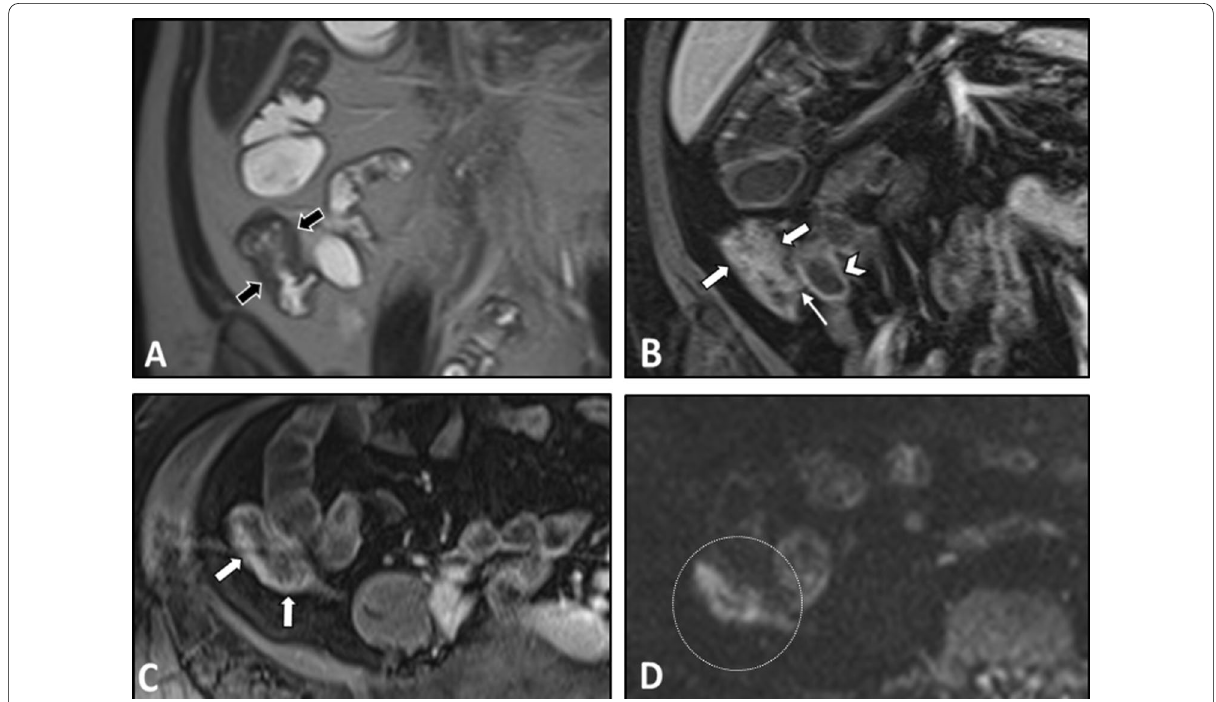
Fig. 13 Intestinal vasculitis in a 26-year-old female with known Behçet’s disease and positive HLA-B5 complaining of episodic RLQ pain. MRE was obtained. Coronal T2-W image ( A ) demonstrates irregular circumferential mural thickening of the cecum and proximal ascending colon (thick black arrows) without mesenteric side predilection or pericolic infiltration. Coronal and axial post-contrast T1-W images ( B , C ) show marked enhancement of thickened colonic wall (thick white arrows) mildly extending to ileocecal valve (thin white arrow) with low-grade mural hyperenhancement in the adjacent terminal ileum (white arrowhead). Axial DWI image ( D ) obtained at a b-value of 800 s/mm 2 reveals restricted diffusion in the thickened cecum (white dotted